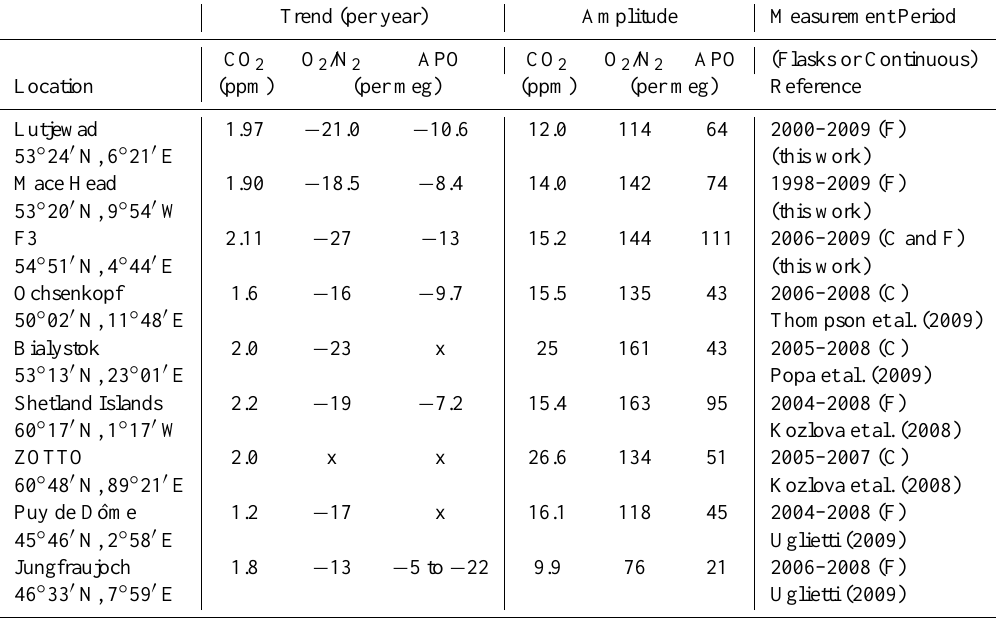
Table 2. CO 2 , δ O 2 /N 2 and APO trend and seasonality from Lutjewad and Mace Head flask samples and for F3 from a combination of flask samples and continuous observations in comparison to observations from other European measurement locations. The error bars for the trends and amplitudes presented in this work are given in Table